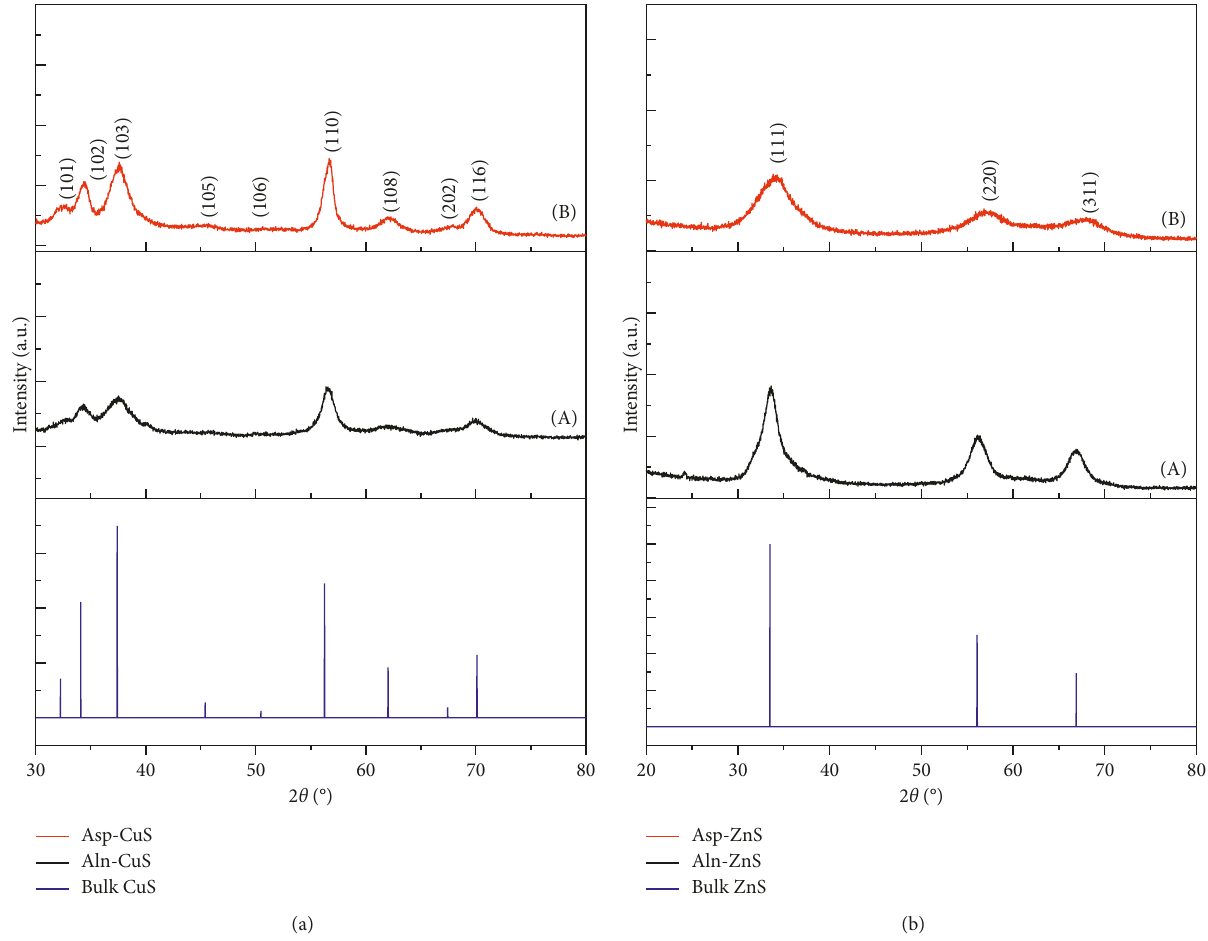
Figure 3: Powder X-ray diffraction patterns of (a) (A) L -alanine-capped CuS nanoparticles and (B) L -aspartic acid-capped CuS nano- particles and (b) (A) L -alanine-capped ZnS nanoparticles and (B) L -aspartic acid-capped ZnS nanoparticles. The bars are from JCPDS standards for hexagonal CuS [06-0464] and cubic ZnS